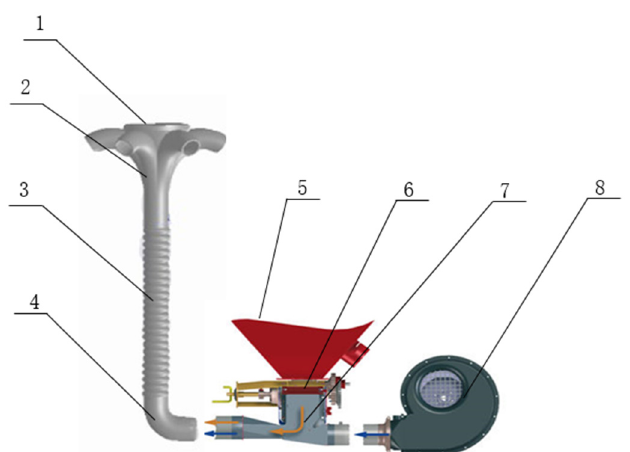
Figure 1. Schematic diagram of pneumatic distribution fertilizer discharge system. 1. Distributor screw cap; 2. Dispenser housing; 3. Corrugated pipe; 4. Elbow; 5. Fertilizer box; 6. Fertilizer quantifier; 7. Jet feeder; 8. Fan.